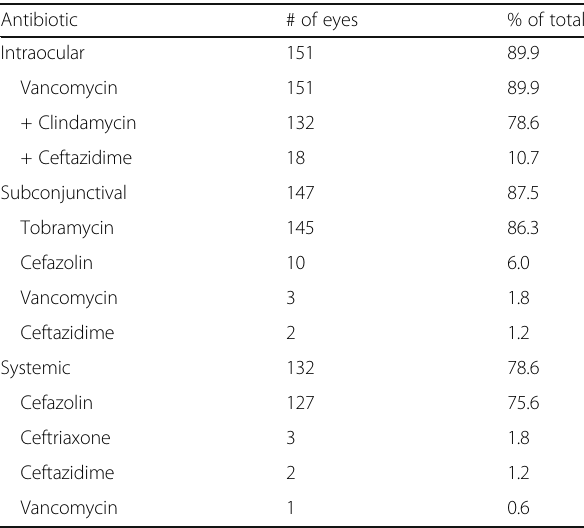
Table 3 Ocular and systemic antibiotics administered at time of ruptured globe repair